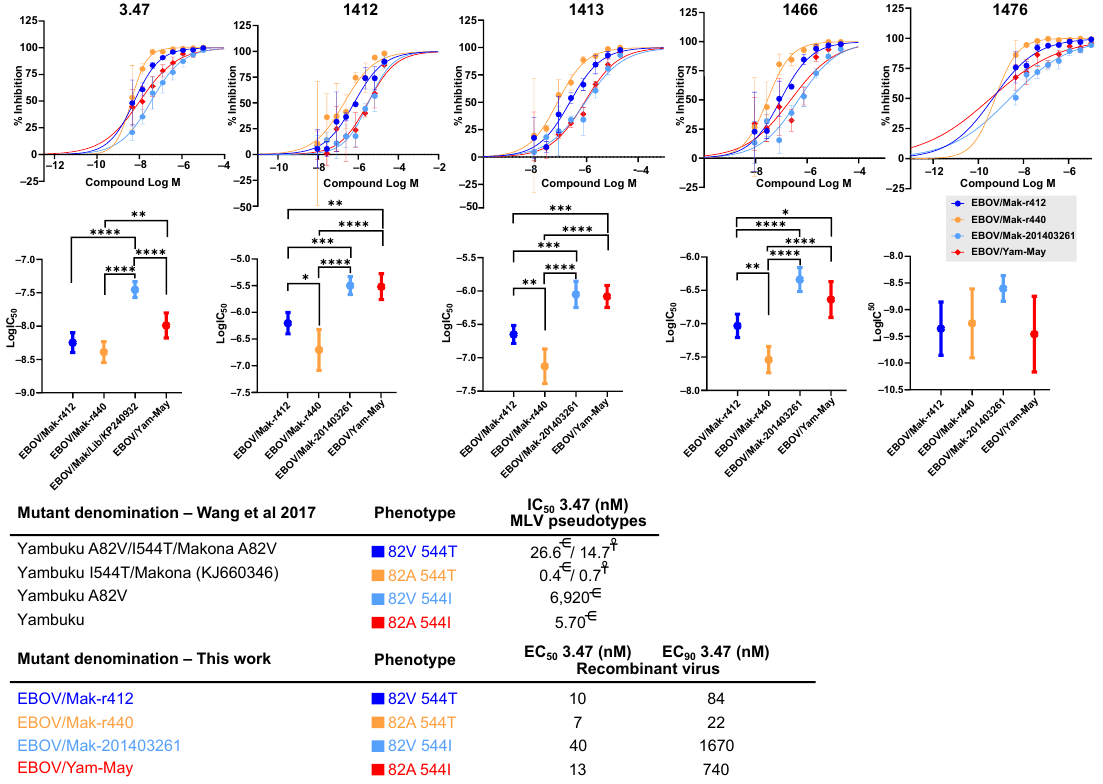
Figure 4. Antiviral activity of the entry inhibitor 3.47 and its analog. Dose response studies were performed on HeLa cells that were pre-treated with increasing concentrations of the indicated compounds for 2 h and subsequently inoculated with the indicated EBOV variant (EBOV/Mak-r412, EBOV/Mak-r440, EBOV/Mak-201403261, or EBOV/Yam-May). Cells were fixed in formalin 48 h after virus inoculation and immunostained for high-content quantitative image-based analysis with EBOV-specific antibodies. Infection rates were normalized to DMSO-treated samples. mean ± s.d. from four replicates are shown. Mean EC 50 values with 95% confidence interval (CI) of each dose response are shown. One-way ANOVA (Tukey’s multiple comparisons test; n = 32) was used to calculate a p value [0.1234 (ns), 0.0332 (*), 0.0021 (**), 0.0002 (***), <0.0001 (****)]. In the cited experiments, murine leukaemia virus (MLV) was pseudotyped with glycoproteins (GP 1,2 s) of EBOV Yambuku-Mayinga € or Makona ¥ containing the indicated